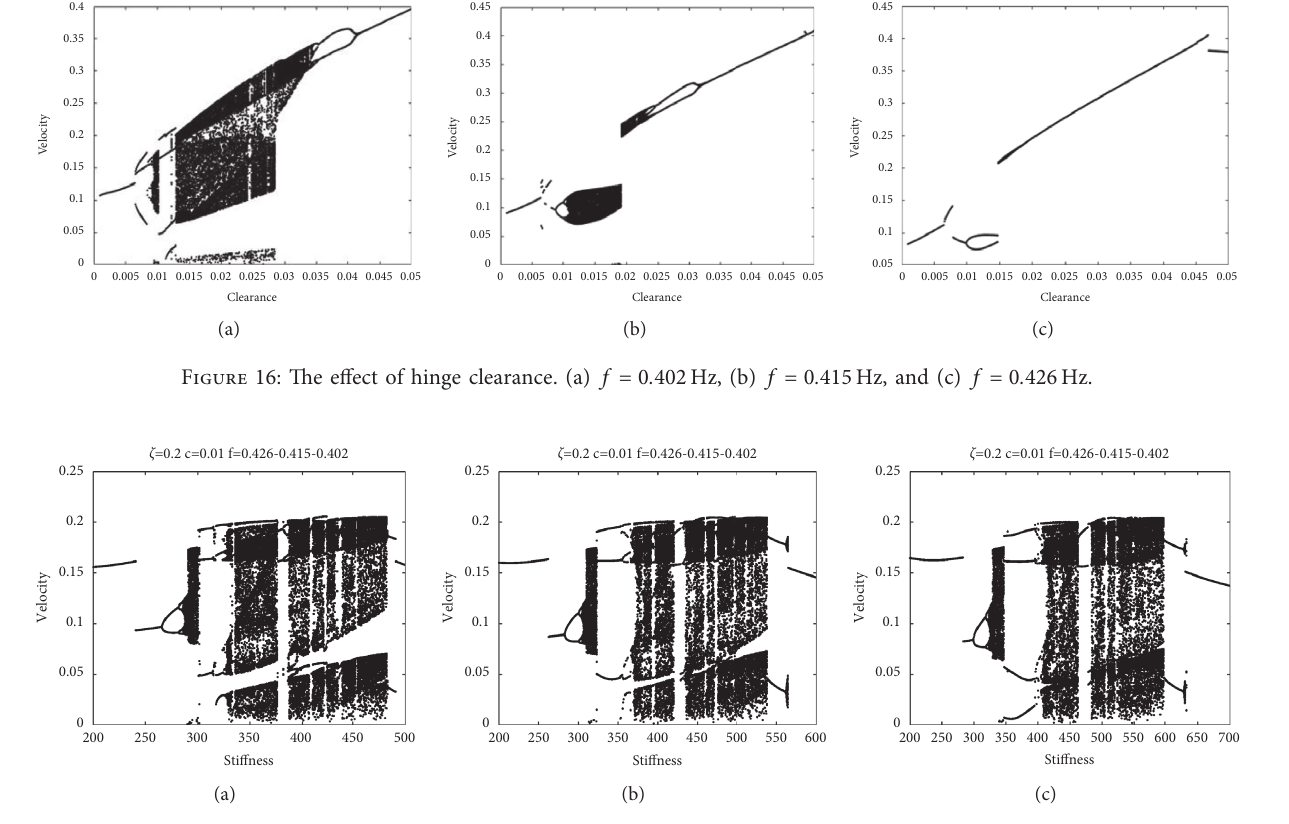
Figure 17: Influence of hinge contact stiffness. (a) f � 0 . 402 Hz, (b) f � 0 . 415 Hz, and (c) f � 0 . 426 Hz.